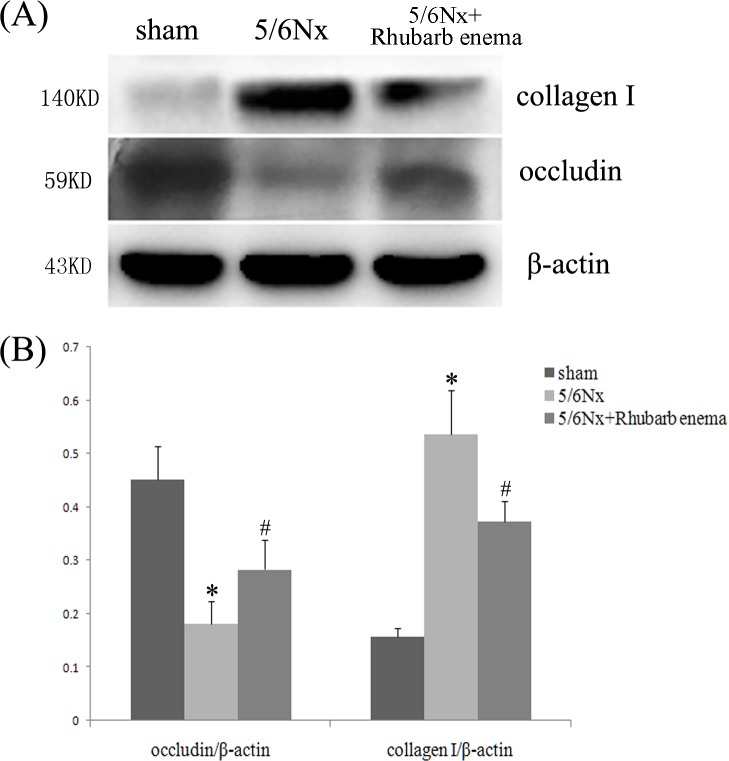
Expressions of occludin and collagen I in kidney tissues.(A) Western-blot analysis of occludin and collagen I in kidney tissues. Lane 1 is the sham operated group, lane 2 is the 5/6 nephrectomized group, and lane 3 is the 5/6 nephrectomized with rhubarb enema treatment group. (B) Occludin and collagen I protein levels. Data are expressed vs. β-actin and were compared by analysis of variance. *P < 0.05 vs. sham operation group. #
P < 0.05 vs. 5/6 nephrectomized group.